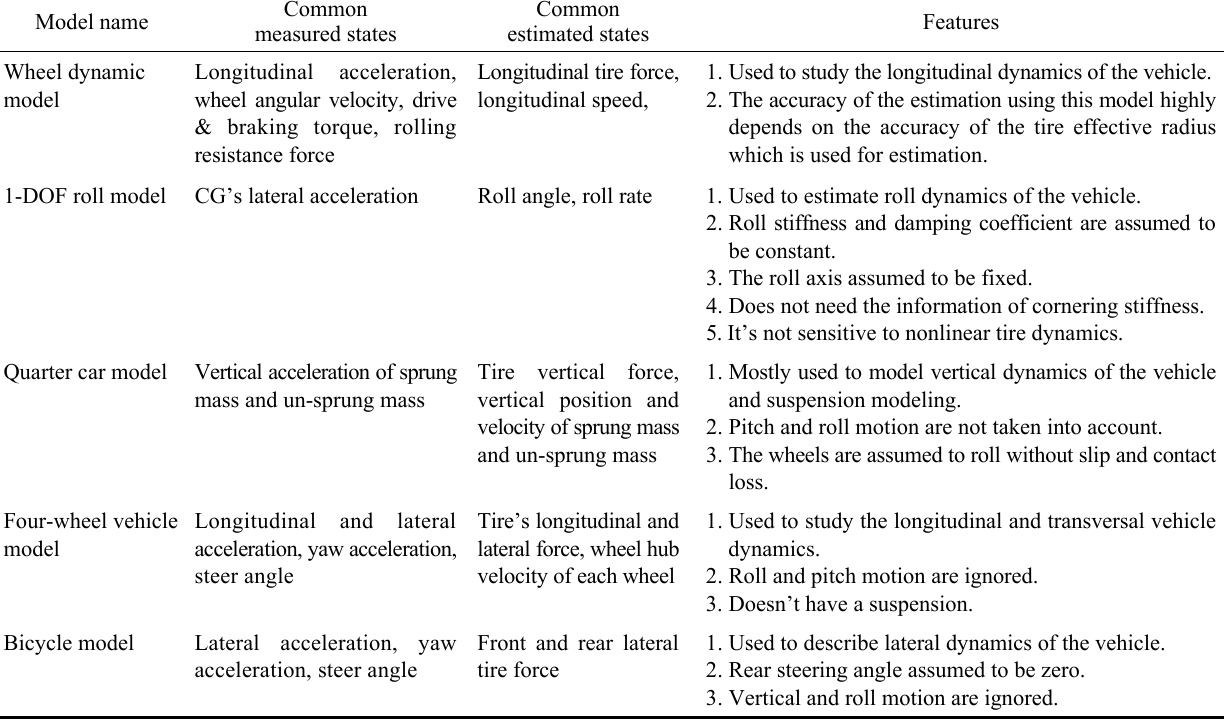
Table 5 Summary of wheel/vehicle dynamic models which are used for friction